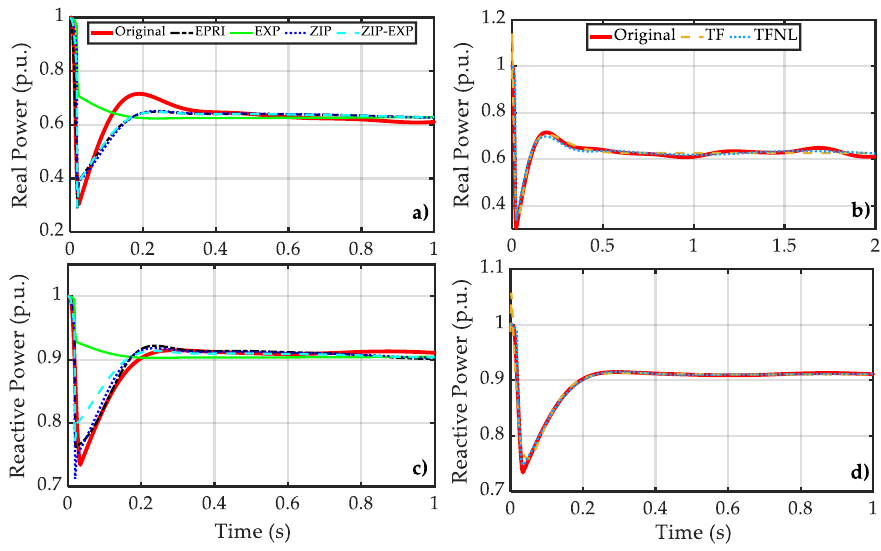
Figure 14. Modelling of ( a ) real and ( b ) reactive power response using static models; Modelling of ( c ) real and ( d ) reactive power response using dynamic equivalent models.